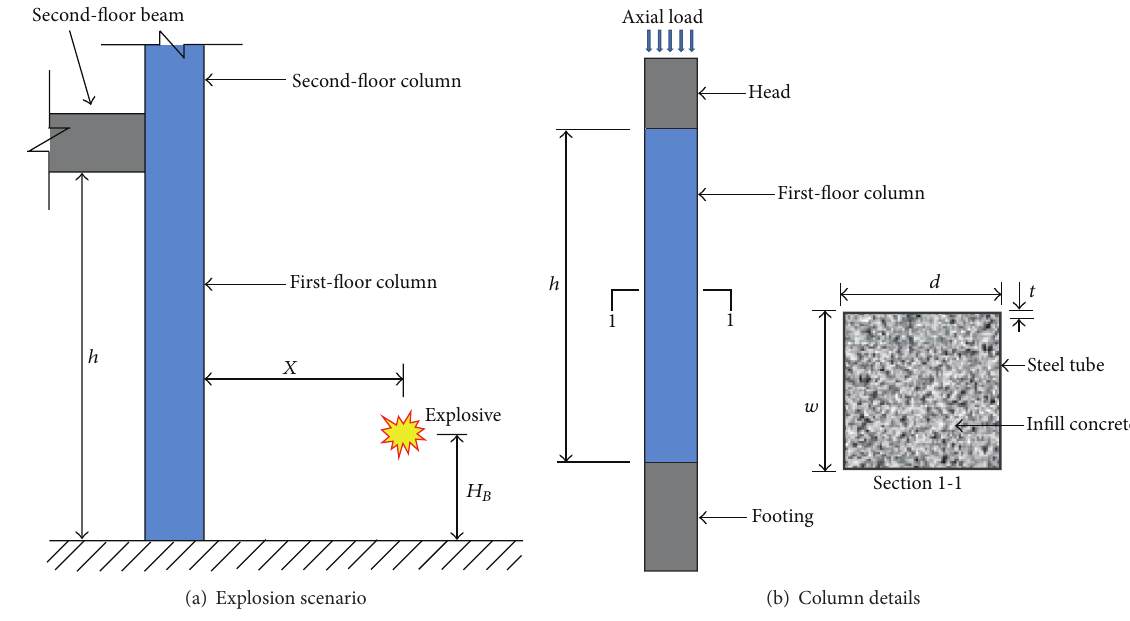
Figure 6: Sketch of the numerical analysis